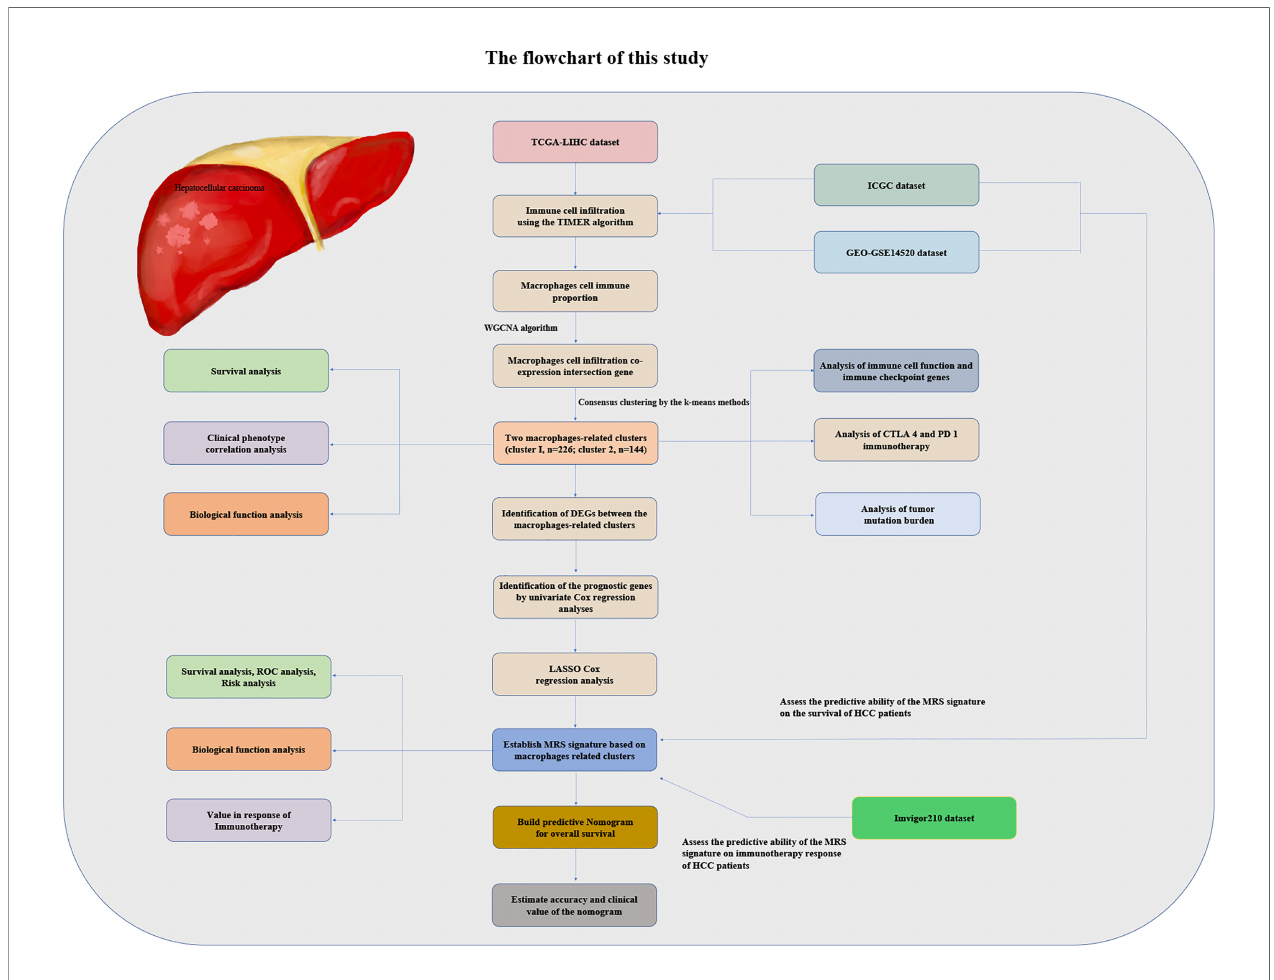
FIGURE 1 | The fl owchart of this